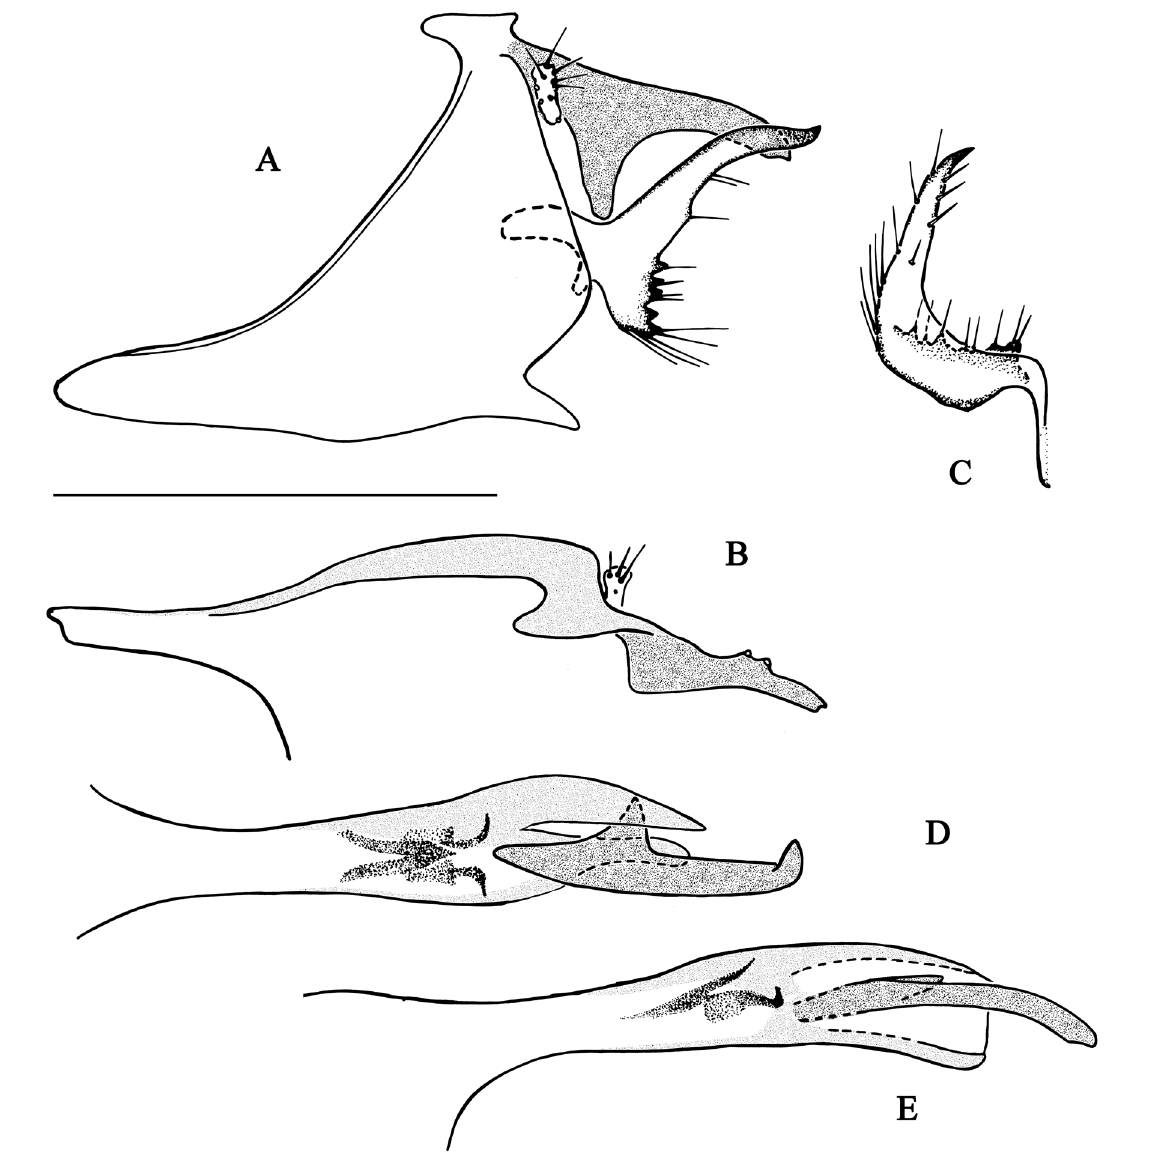
Fig. 3. Chimarra cebegepi sp. nov. A–B . Abdominal segments IX and X. A . Lateral view. B . Dorsal view (partim). C . Inferior appendage, dorsal view. D–E . Phallic apparatus. D . Dorsal view. E . Lateral view. Scale bar = 0.5